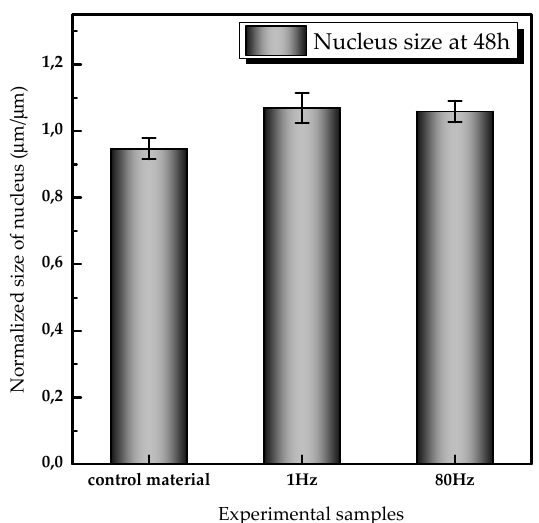
Figure 7. Average size of the diameter of nucleus normalized to control samples at 48 h after continuous mechanical stimulation (number of nuclei analyzed > 300 for both control and experimental groups).